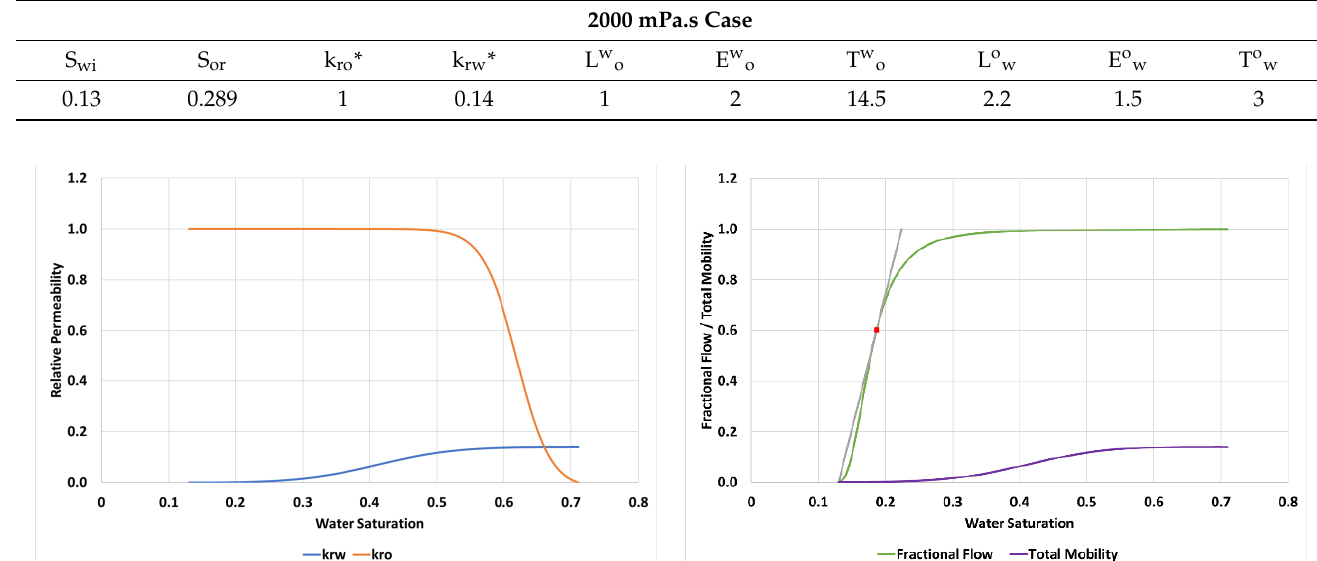
Table 3. LET input parameters for the 2000 mPa.s oil displacement case.